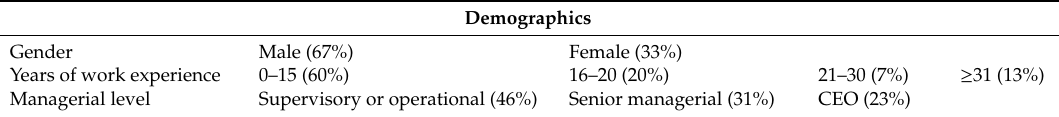
Table 4. Demographics of